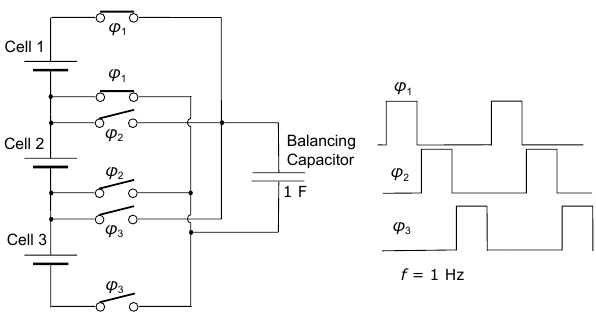
Figure 18. Circuit for active balancing of a 3S1P